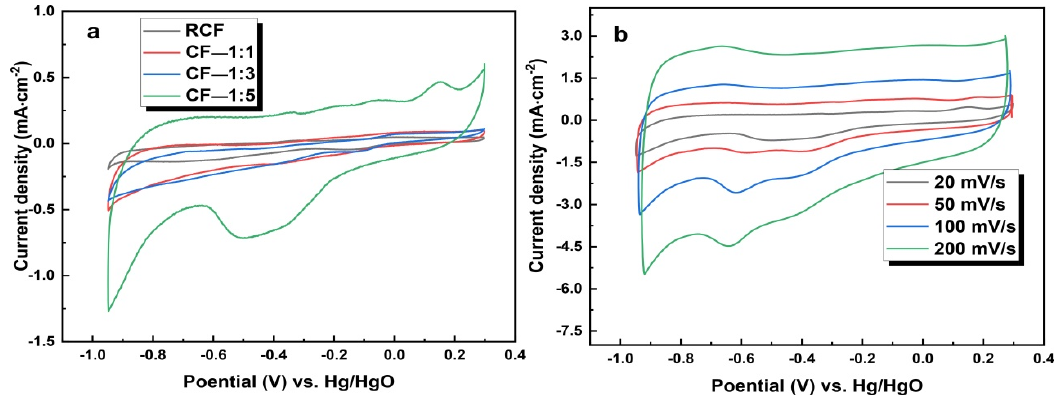
Figure 7. ( a ) CV diagram of RCF and modified CF, ( b ) changes of CF—1:5 electrode with scavenging speed electrode CV.